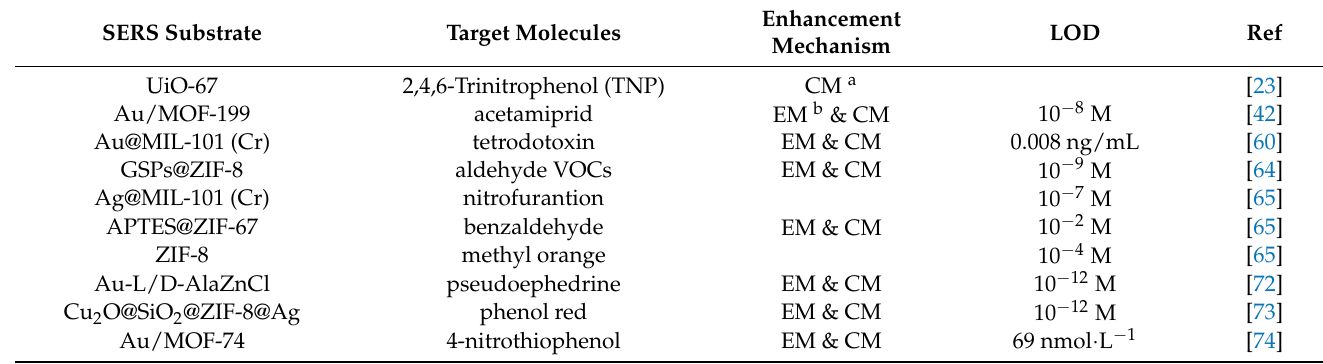
Table 2. Summary of MOF and MOF-plasmonic system-based SERS applications.